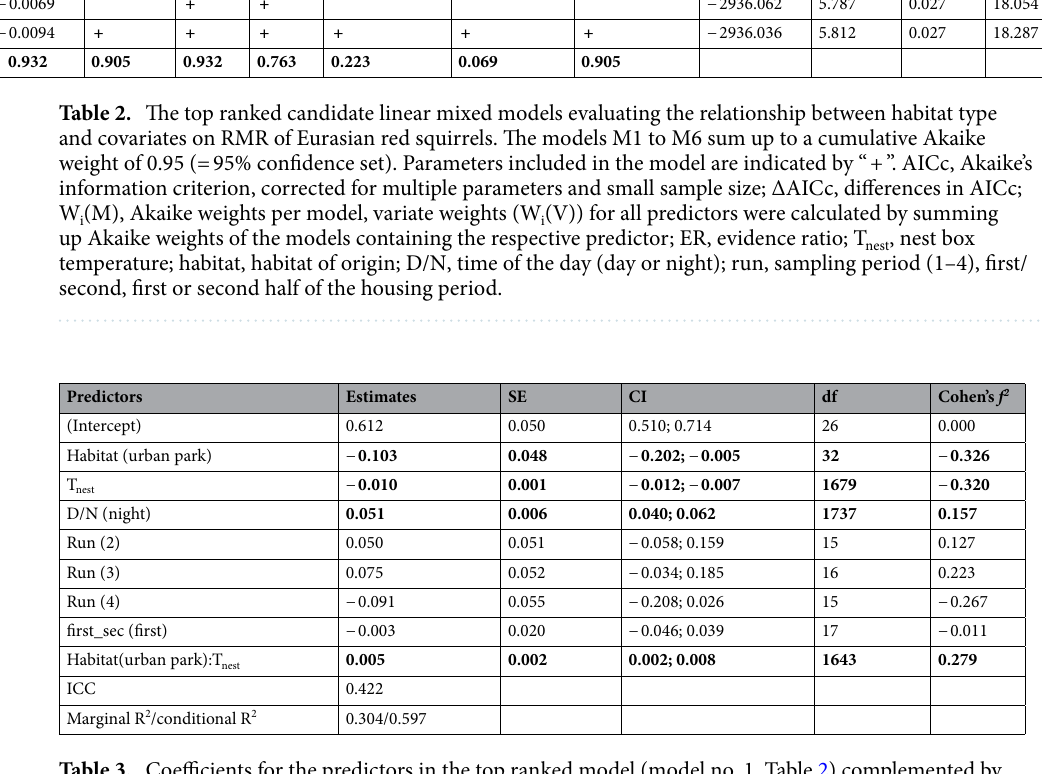
Table 3. Coefficients for the predictors in the top ranked model (model no. 1, Table 2) complemented by standard errors (SE), confidence intervals (CI), degrees of freedom (df), standardized effect sizes (Cohen’s f 2 ) as well as the intraclass correlation coefficient (ICC) and the marginal/conditional R 2 . Bold predictors indicate statistical significance with CI’s not overlapping